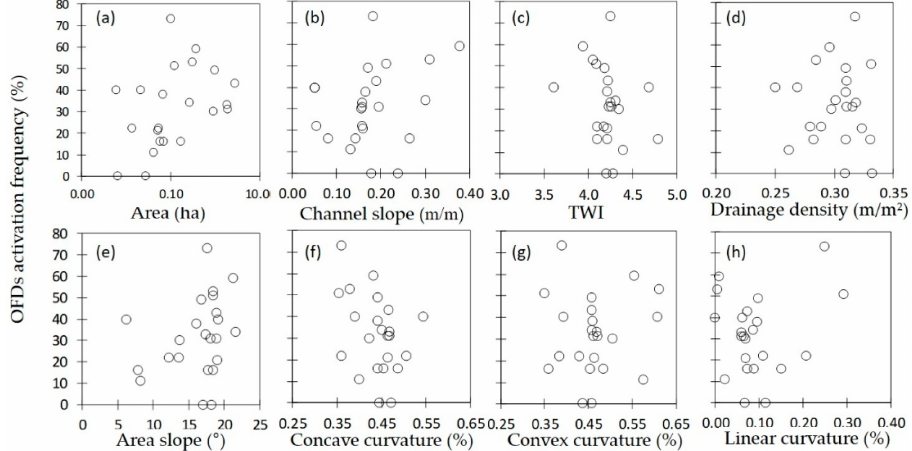
Figure 7. Overland-flow activation frequency in relation to topographic indices. ( a ) Area. ( b ) Channel slope. ( c ) Topographic Wetness Index. ( d ) Drainage Density. ( e ) Area Slope. ( f ) Concave Curvature. ( g ) Convex Curvature. ( h ) Linear curvature. Each circle represents one of the 23 overland-flow detectors.